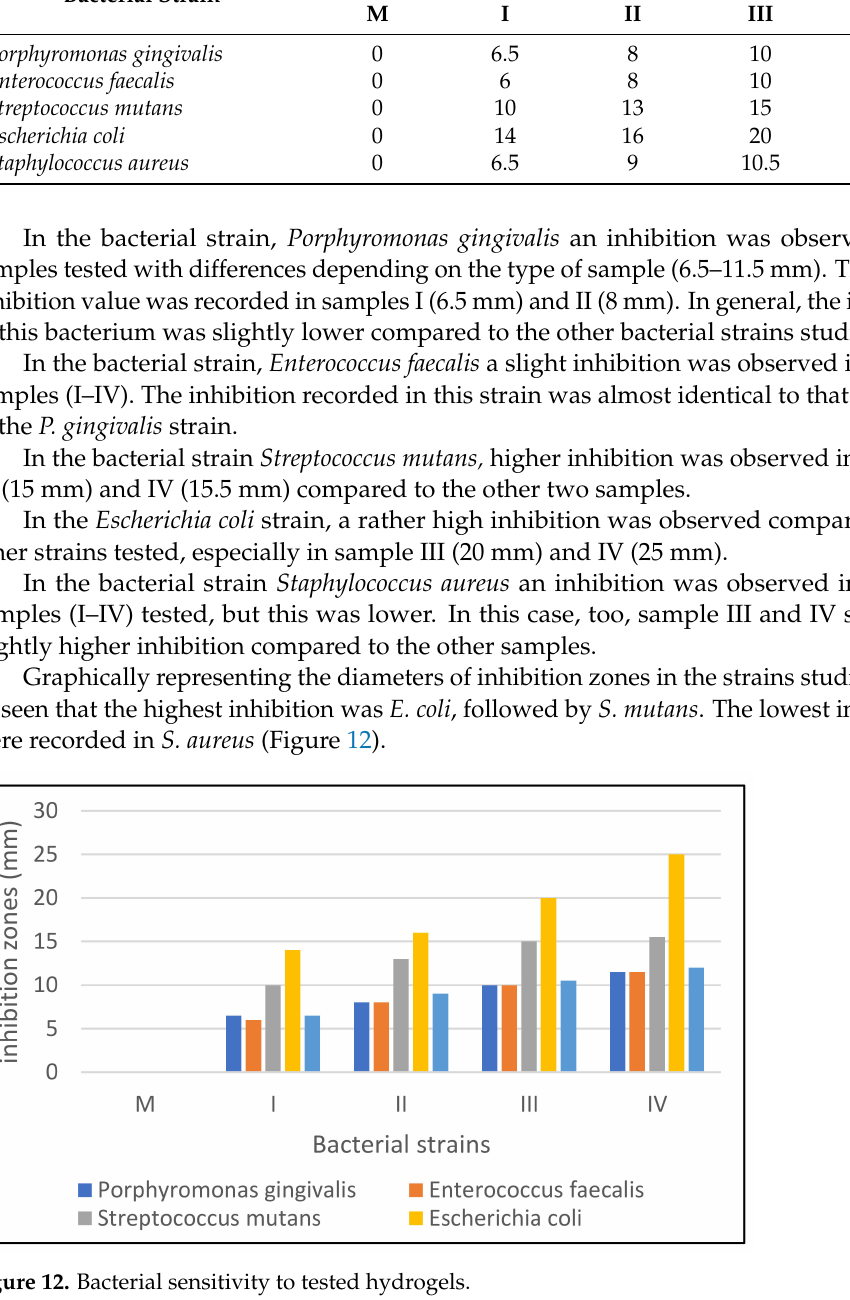
Figure 12. Bacterial sensitivity to tested